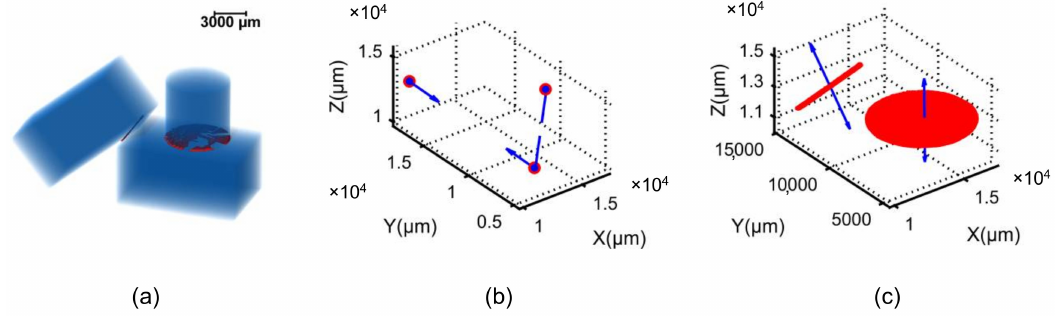
Figure 6. Validation of the code for determining coordination number, branch vector and contact normal vector: ( a ) three regular-shaped aluminum blocks in contact, ( b ) branch vectors, ( c ) contact normal